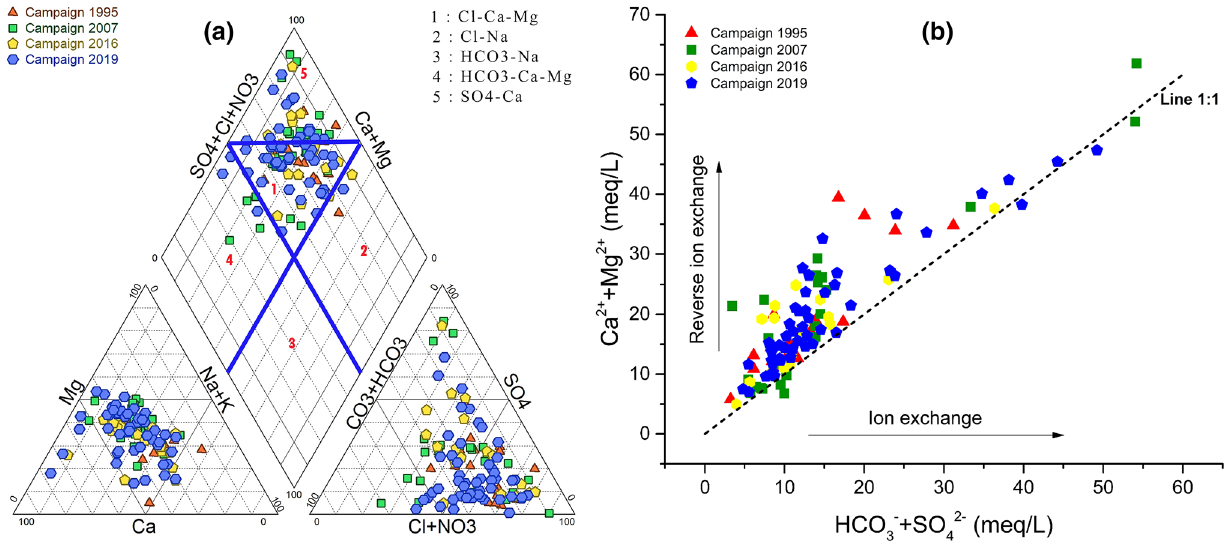
Fig. 4 Hydrochemistry of the four campaigns 1995, 2007, 2016 and 2019 in the study area. a Piper diagram; b correlation between Ca 2+ + Mg 2+ (meq/L) and HCO 3− + SO 42− (meq/L)